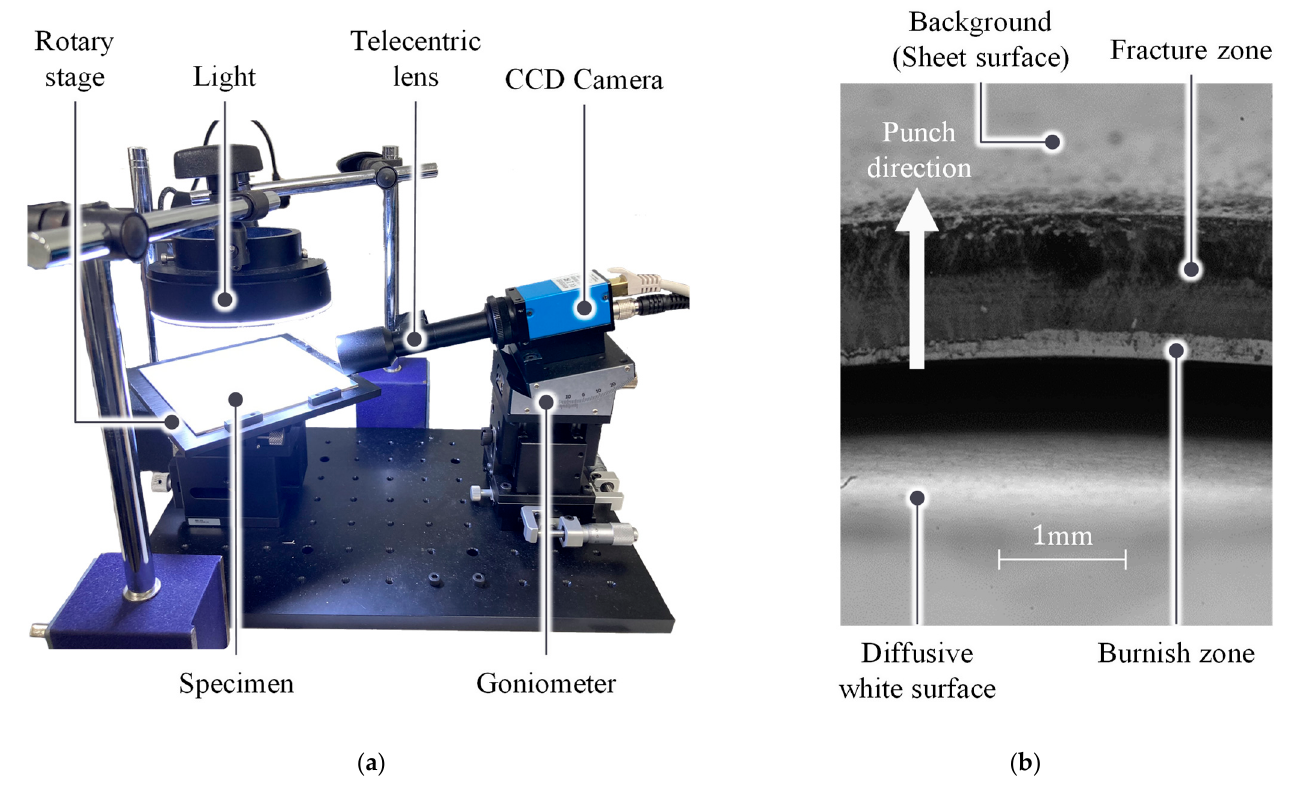
Figure 5. Experimental set-up for edge capturing: ( a ) camera setup for capturing the edge, and ( b ) example of the captured edge.